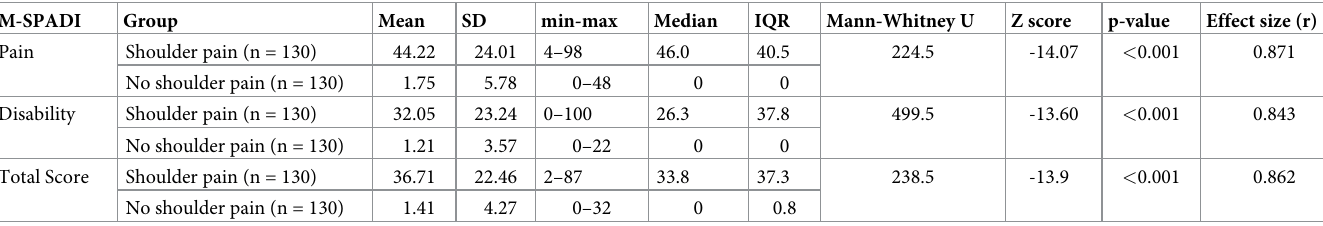
Table 5. Mann-Whitney U results comparing participants with and without shoulder pain. M-SPADI